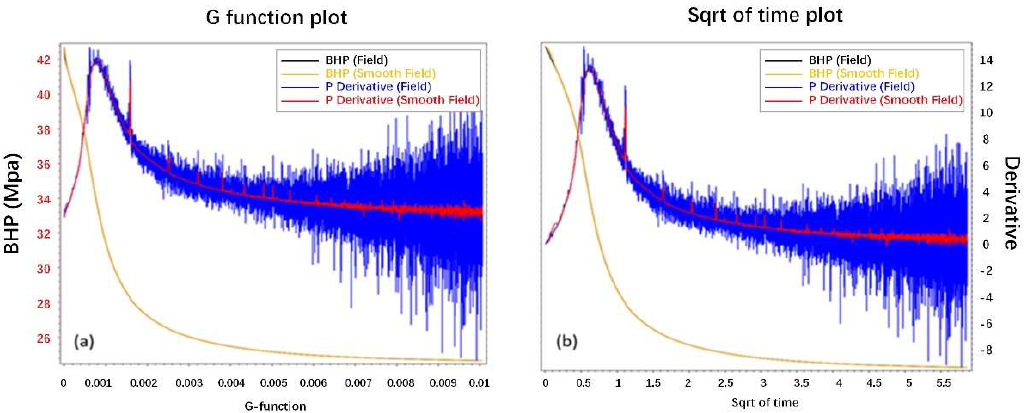
Figure 8. Well-A DFIT data in ( a ) G-function and ( b ) square root of time plots.